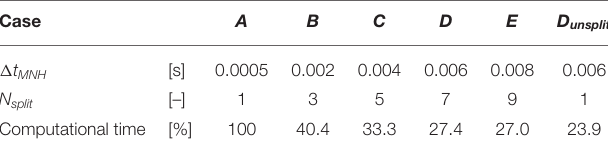
TABLE 1 | Time step values used to obtain different time-splitting